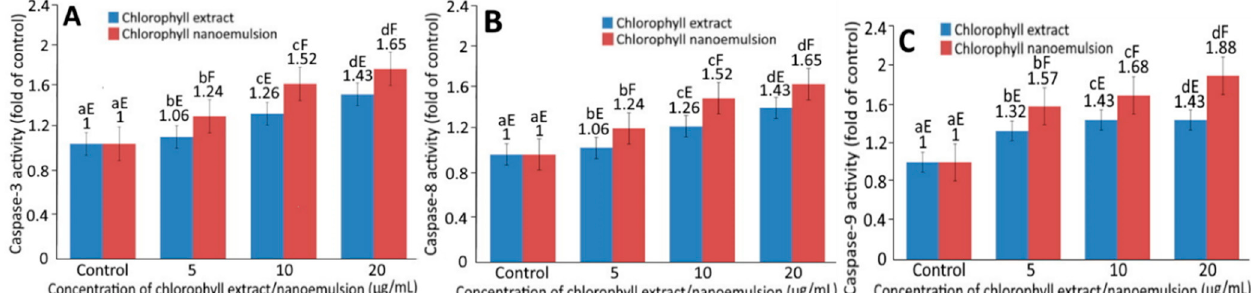
Figure 6. Activities of caspase-3 ( A ), caspase-8 ( B ) and caspase-9 ( C ) in human melanoma cells A375 as affected by different concentrations of chlorophyll extract and nanoemulsion. Data represent mean ± standard deviation ( n = 3) with different small letters (a–d) within the same treatment for different concentrations as well as different capital letters (E–F) within the same concentration for different treatments indicating significantly different values at p < 0.05.